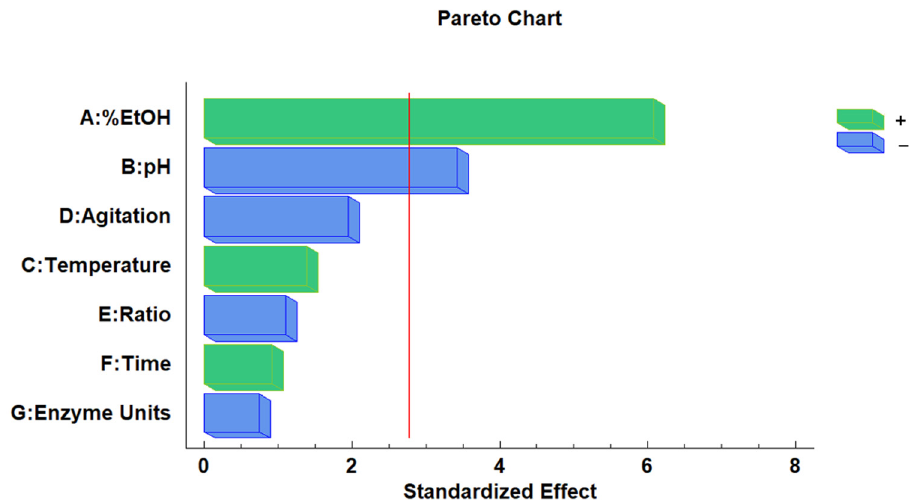
Figure 2. Pareto Chart of the PB design corresponding to the extraction of anthocyanin. A: %EtOH in the solvent; B: solvent pH; C: temperature; D: agitation; E: ratio; F: time of extraction; G: units of enzyme per gram of sample.